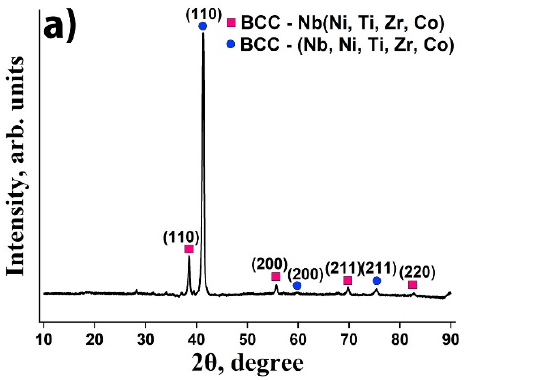
Figure 2. XRD patterns of Nb 20 Ni 20 Ti 20 Zr 20 Co 20 ( a ) and Nb 40 Ni 25 Ti 18 Zr 12 Co 5 ( b ) high entropy alloys annealed at 800 ◦ C for 10 h.